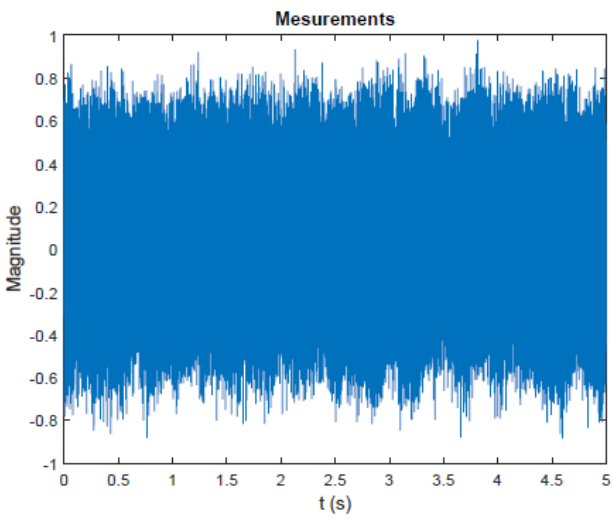
Figure 5. Measurement from microphone